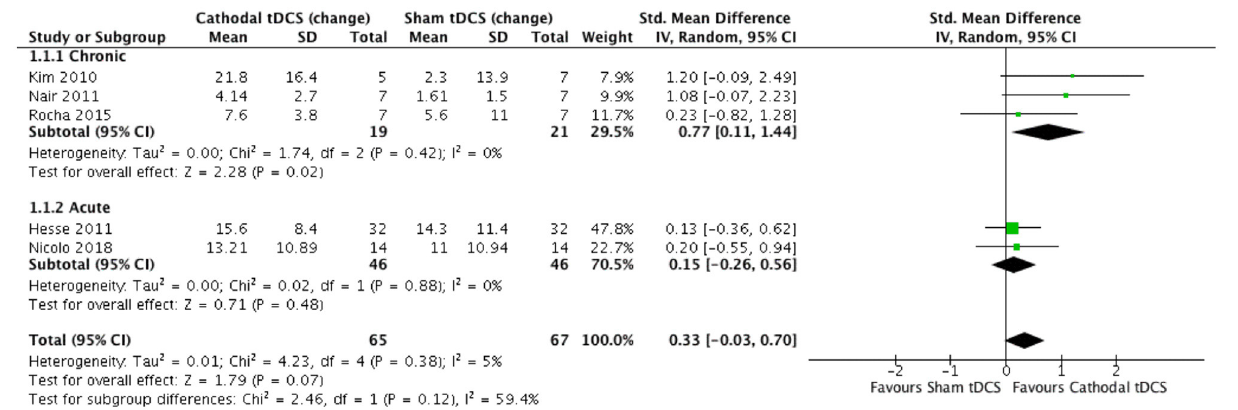
FIGURE 2 | Effect (standardized mean difference) of cathodal transcranial direct current stimulation (tDCS) vs. sham tDCS on the change in Fugl–Meyer upper extremity score.